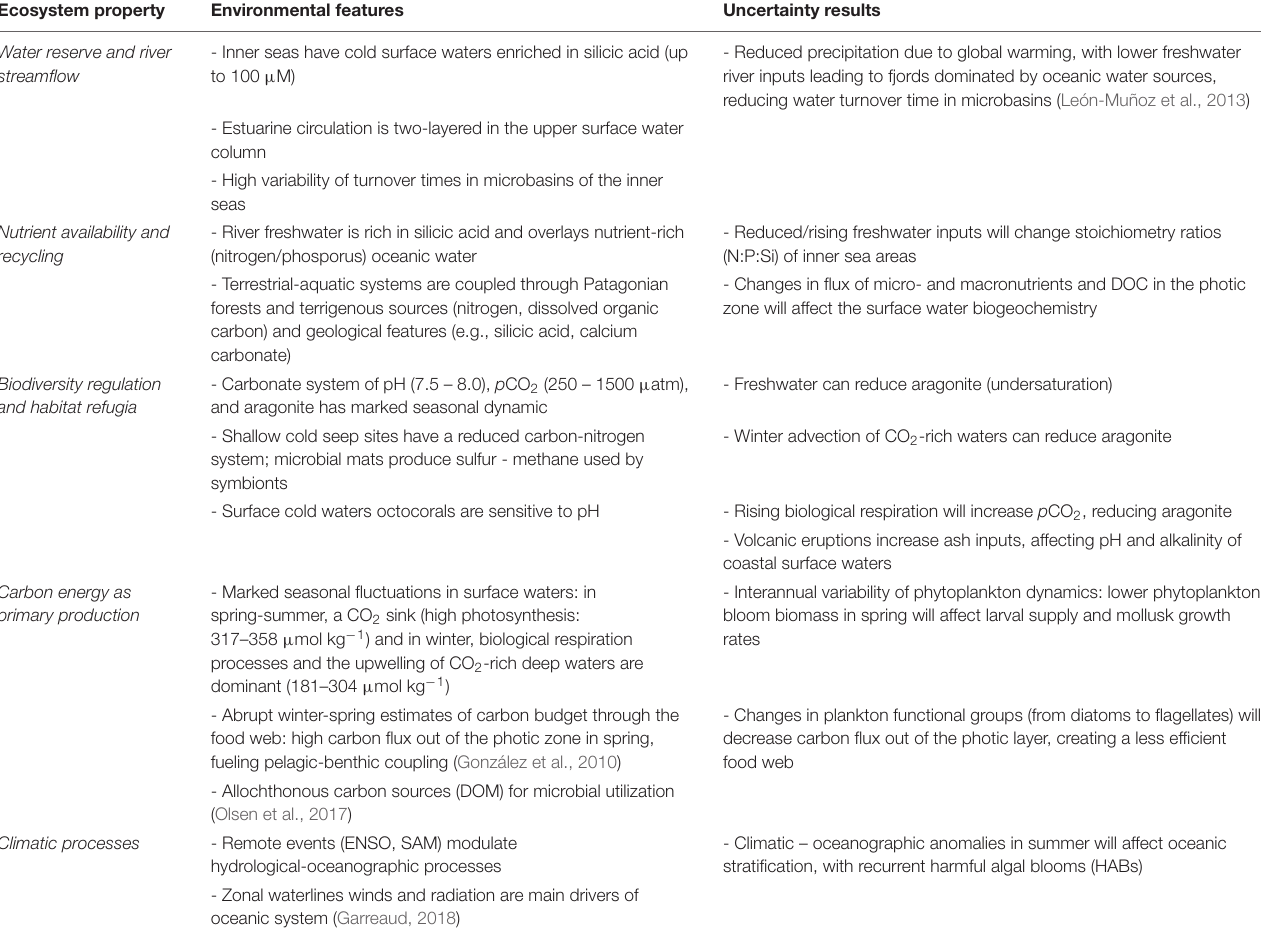
TABLE 1 | Main properties (ecosystem scale) that may be supported by the principal climatic, hydrological, and oceanographic features considering current and future scenarios of uncertainty in the Patagonian marine ecosystem. Ecosystem